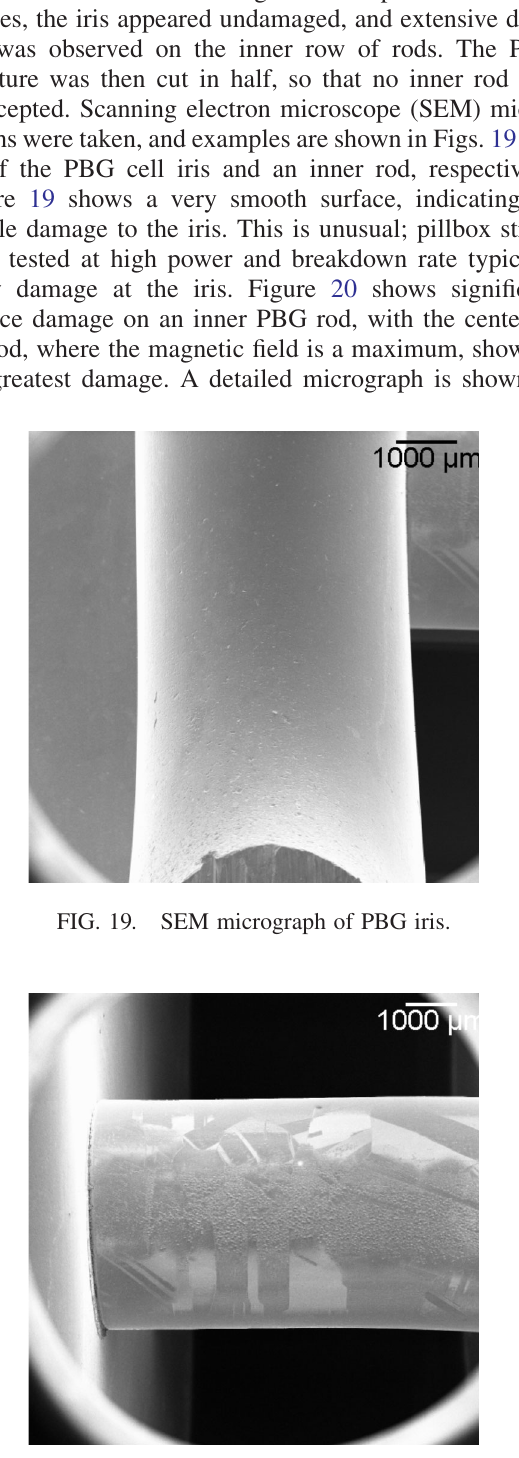
FIG. 20. SEM micrograph of inner